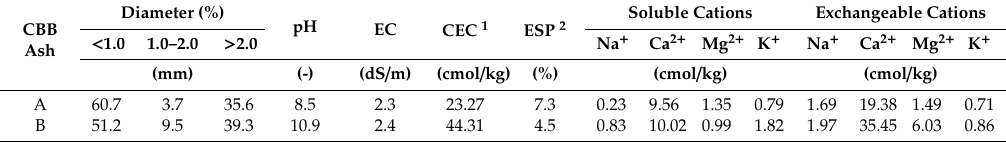
Table 1. Chemical properties and particle diameter in coal bio-briquette ashes (CBB ash A and B). CBB Ash